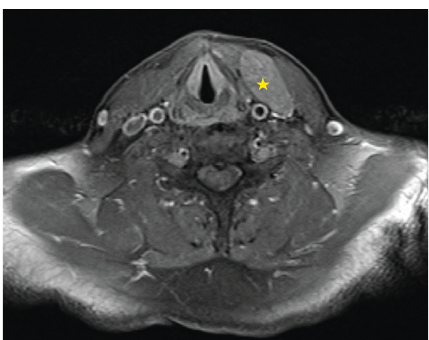
Figure 1: MRI T1 FatSat axial showing lesion (star) within left omohyoid muscle.